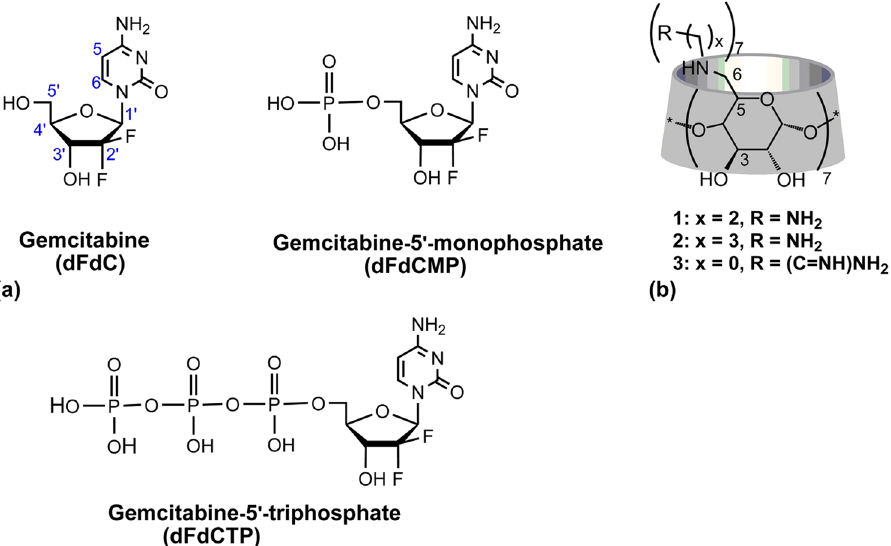
Figure 1. The structures of ( a ) gemcitabine (dFdC), gemcitabine monophosphate (dFdCMP) and gemcitabine triphosphate (dFdCTP) and ( b ) the positively charged β CDs used